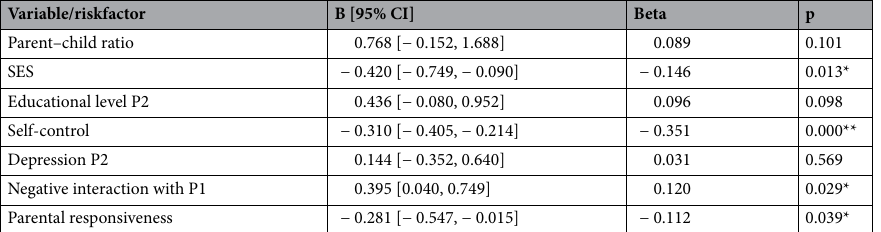
Given the significant relationship between COVID-impact and youth well-being it is imperative to better understand how risk exposure accounts for the negative effects on youth’s lives. It was hypothesized that the relationship between both the sum (ARM) and accumulation (CRM) of risk factors and lower psychological well-being was reinforced by negative COVID-impact. During the intelligent lockdown, both ARM and CRM